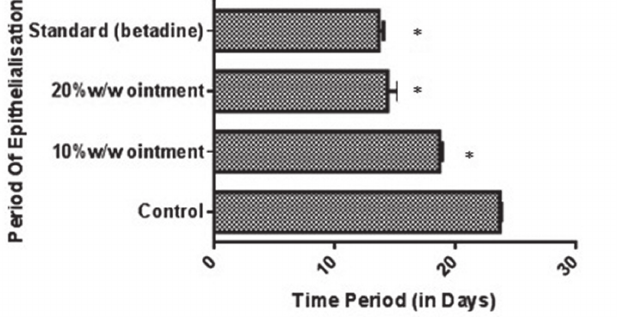
FIGURE 3 - Epithelialization Periods in different treatment groups in Burn wound models.